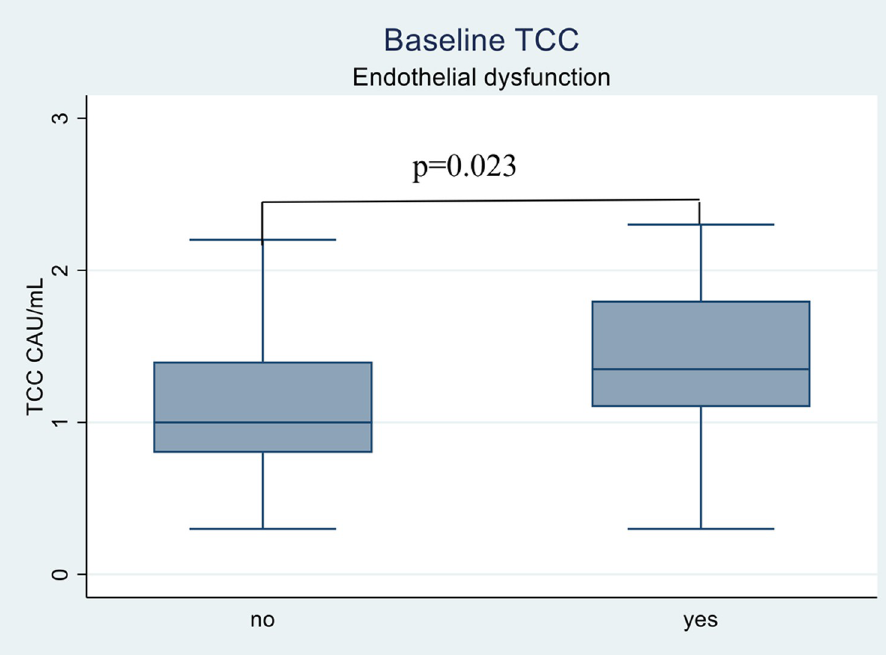
Fig 1. Baseline TCC in patients with and without endothelial dysfunction. Boxplots presenting the distribution of the baseline values of TCC in patients with and without endothelial dysfunction. The lines inside the boxes show the median, bottom and top of the box represent 25 and 75 percentile and whiskers represent minimum and maximum values. Endothelial dysfunction defined as reactive hyperemia index � 1.67. Values are given in median. TCC: Soluble terminal complement complex.